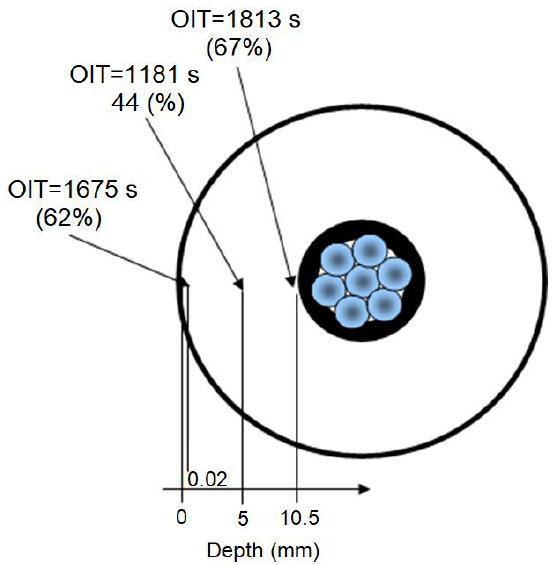
× 100 (isother- OIT 0